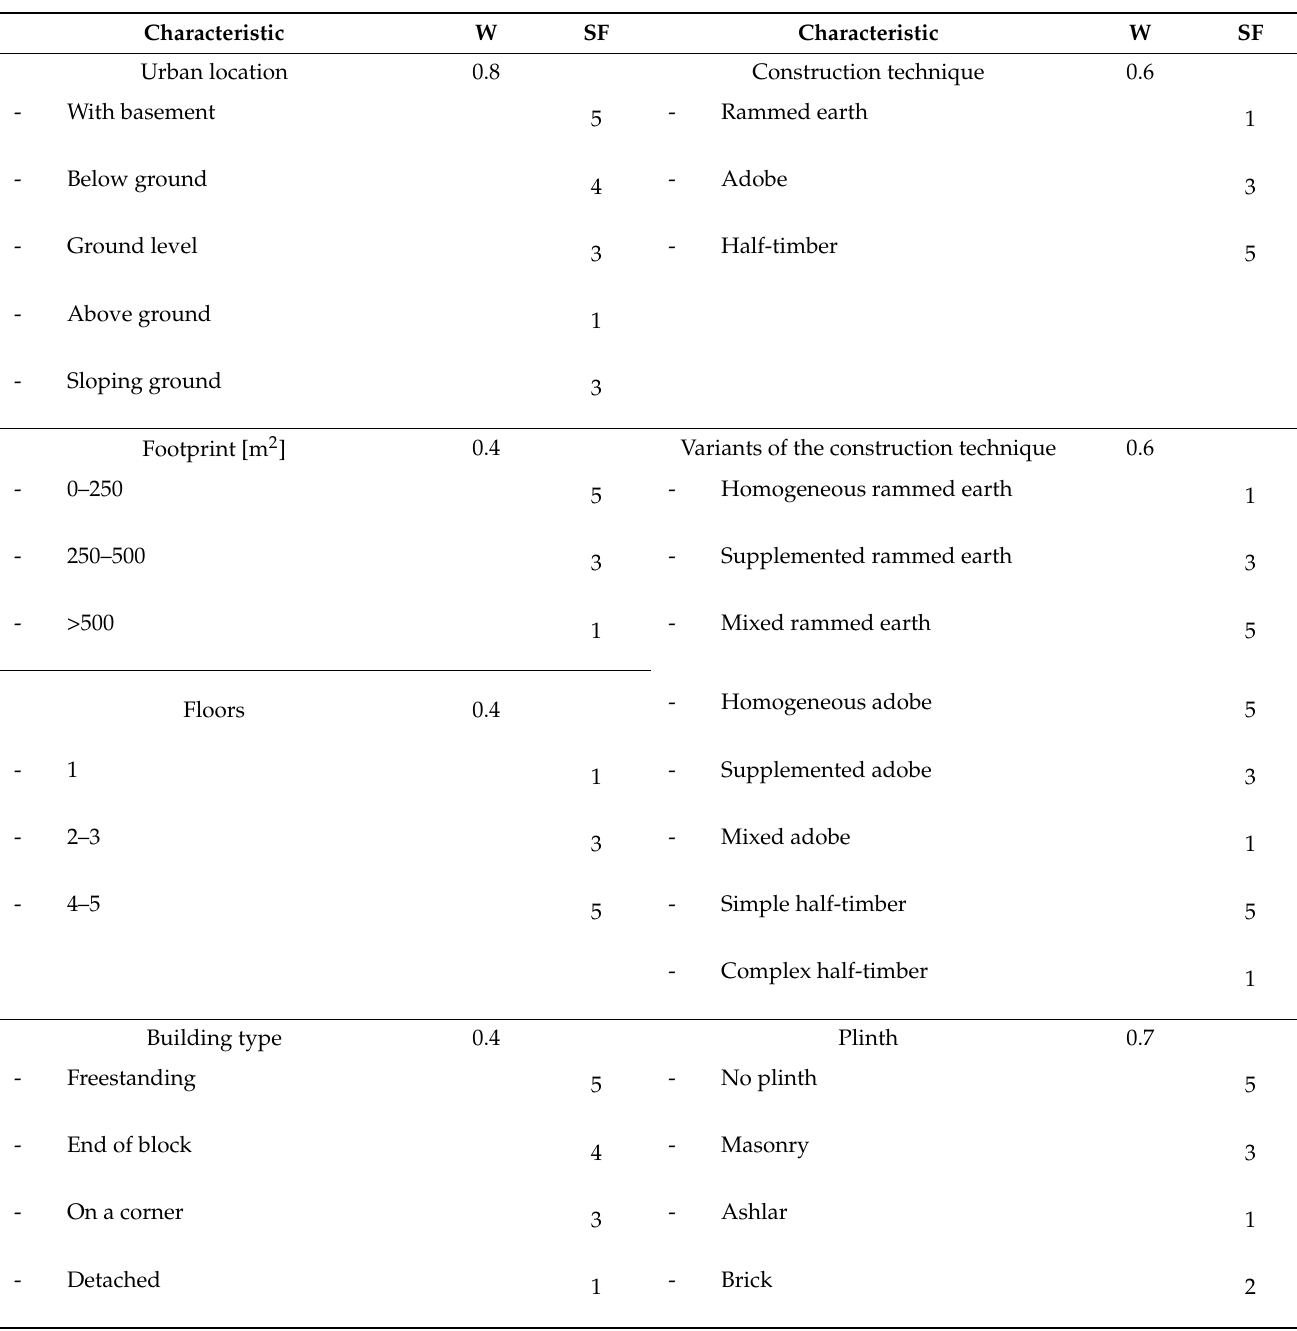
Table 2. Earthen architecture susceptibility